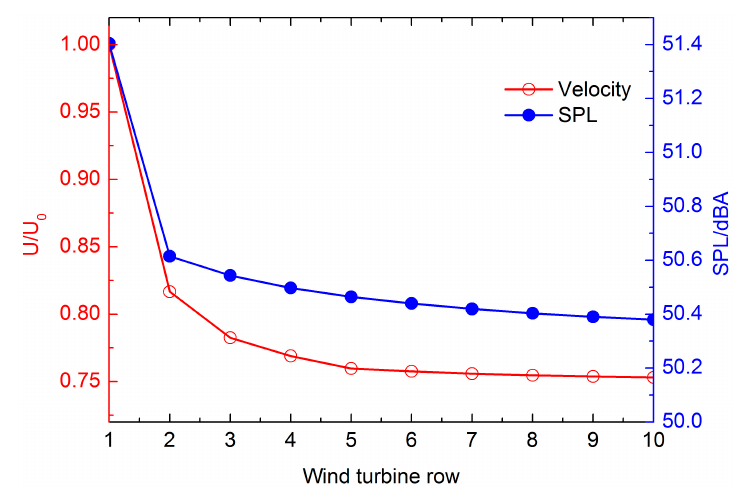
Figure 11. Contours of the wake velocity for 10 wind turbines.